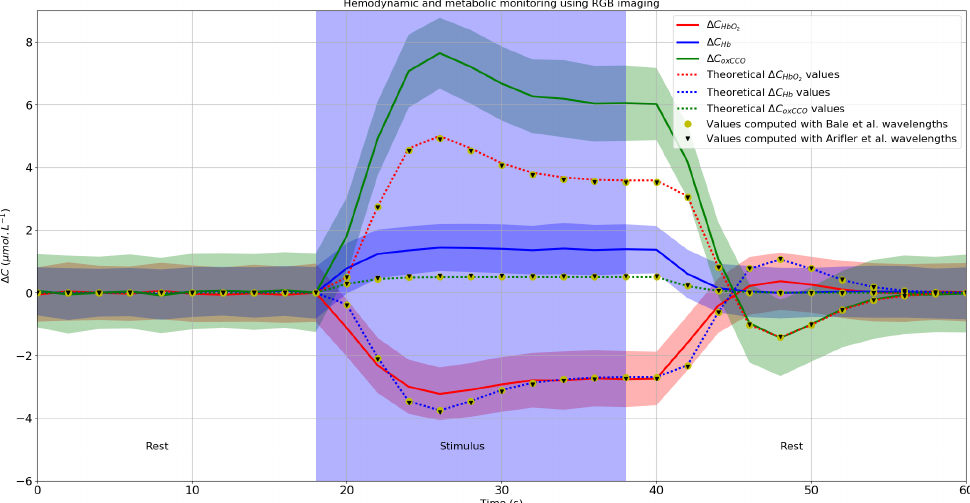
Figure 13. Hemodynamic and metabolic monitoring following neuronal activation computed with RGB imaging. The dashed lines represent the theoretical hemodynamic and metabolic responses following the neuronal stimulation. The dispersion ranges of the measurements are represented by colored areas. The concentration changes averaged over the 10 3 noisy measurements are represented in solid lines. The concentration changes’ time courses computed with the 121 wavelengths included between 780 nm and 900 nm [23] are represented with yellow points. The ones computed with Arifler et al.’s wavelengths [27] are represented with black triangles. The blue rectangle represents the “patient” physiological stimulus.